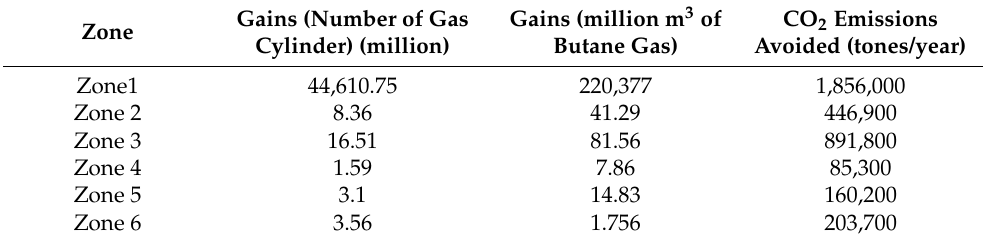
Table 10. The annual CO 2 emissions avoided by the integration and the generalization of the